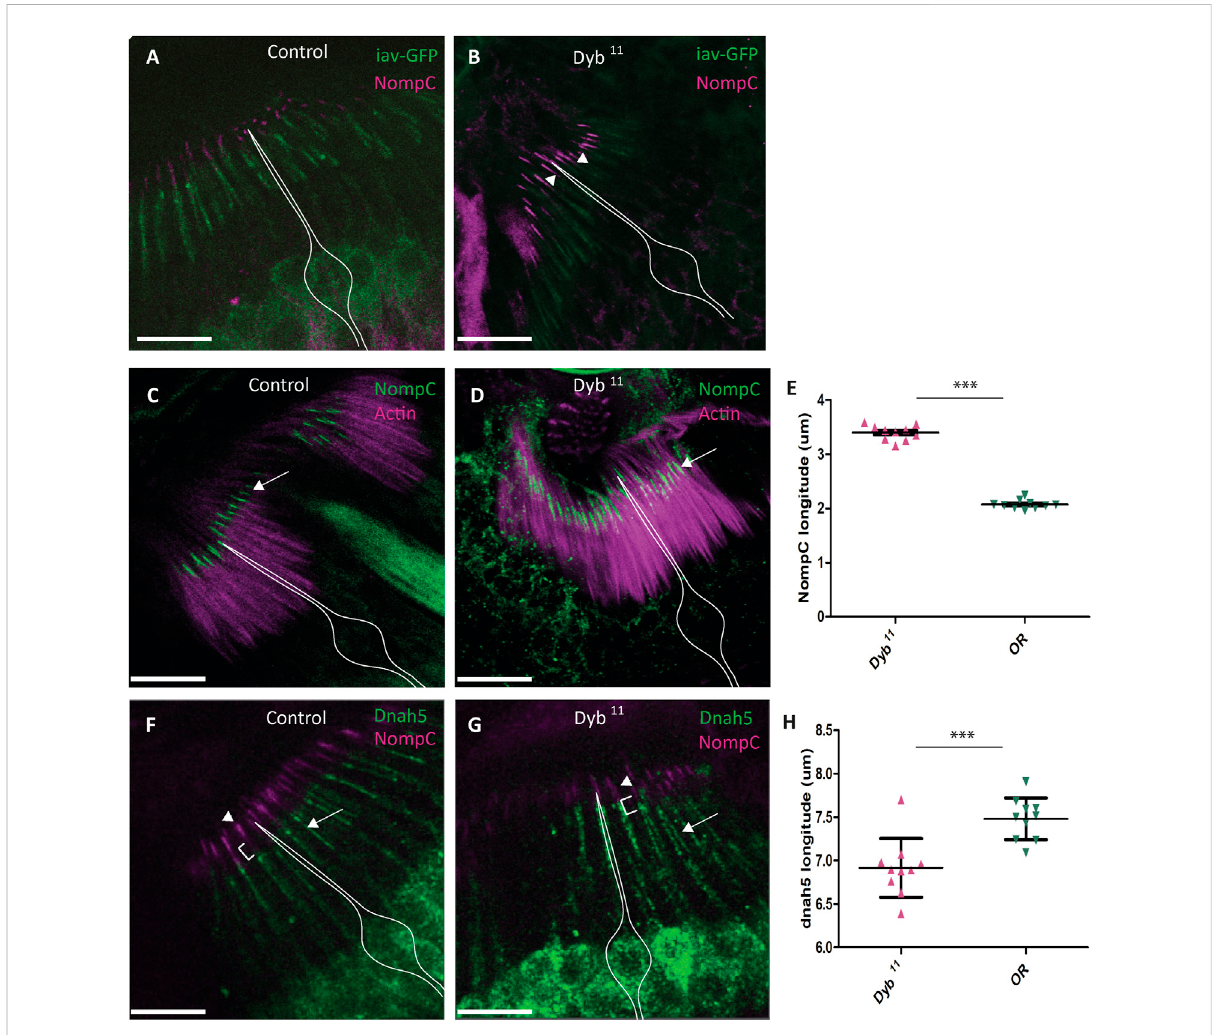
FIGURE 8 Location and distribution of dynein heavy chain Dnah5 and TRP channels, NompC and Iav, in Dyb 11 mutant JO neurons. Confocal images of immuno fl uorescence in JO at pupal stage. (A) In control JO (OR), TRP channels Iav (green) and NompC (magenta) localise to separate zones of the sensoryneuronciliarydendrites. (B) Inthe Dyb 11 mutantJO,adiffusedistributionofNompC(magenta),causesittooverlapwithIav(green)inthecilia dendrites(arrowhead).Scalebar:10 μ m.Thewhiteoutlinerepresentsthelocationofsensoryneurons. (C) TRPchannelNompC(green)localise to the extreme tips of the cilia dendrites in the OR control (white arrow). The actin marker identi fi es the scolopale cell. (D) In Dyb 11 , NompC is most diffusely located in the ciliary dendrites (white arrow). The actin marker identi fi es the scolopale cell. (E) Length of ciliary extent of NompC in Dyb 11 mutant and control antennae. In three independent experiments, NompC extent was measured in 10 cilia from each of 10 JO (100 cilia) for both controls and Dyb 11 . In the graph, each dot represents the mean of 10 cilia from one antenna. Comparison was performed by Mann Whitney